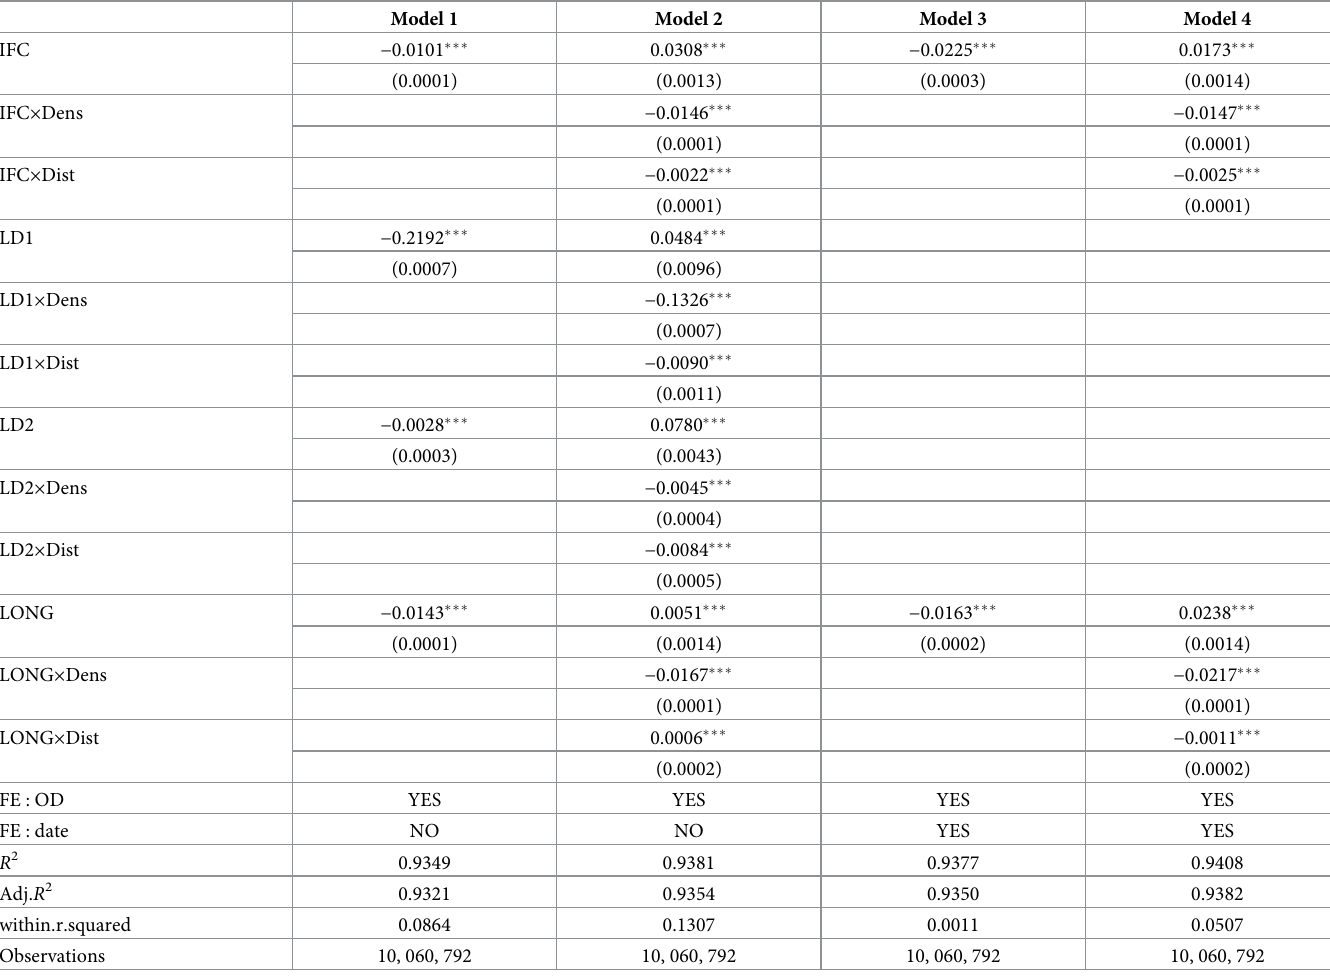
Table 1. Baseline